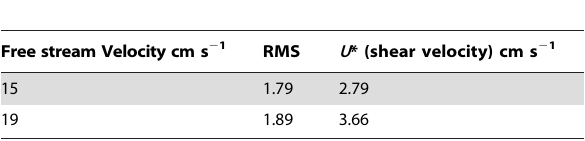
Table 2. Hydrodynamic conditions measured in the Texas A&M University – Corpus Christi (TAMU-CC)